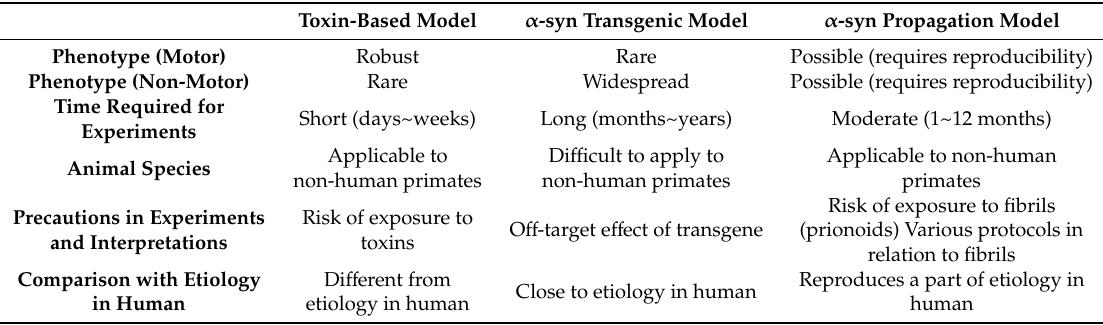
Table 1. Advantages and disadvantages of each